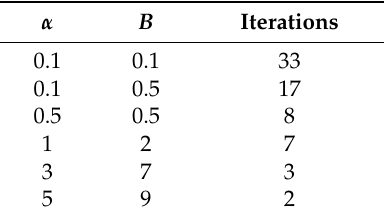
Table 4. The number iterations taken to find an optimal